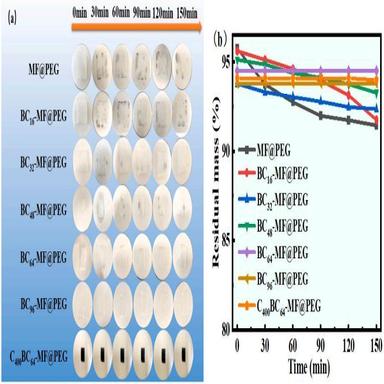
(a) Anti-leakage test plots of FCPCMs at different time, and (b) residual mass ratio.